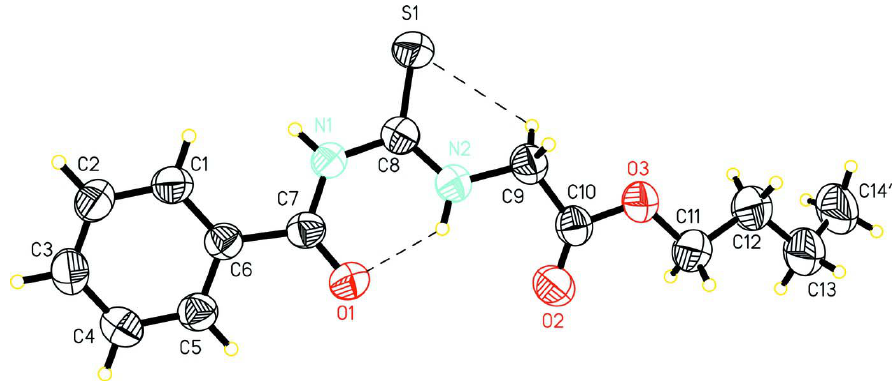
Figure 2 The molecular structure of (I) showing the minor (20% occupancy) disorder component of the butyl terminal carbon atom, with displacement ellipsods are drawn at the 50% probability